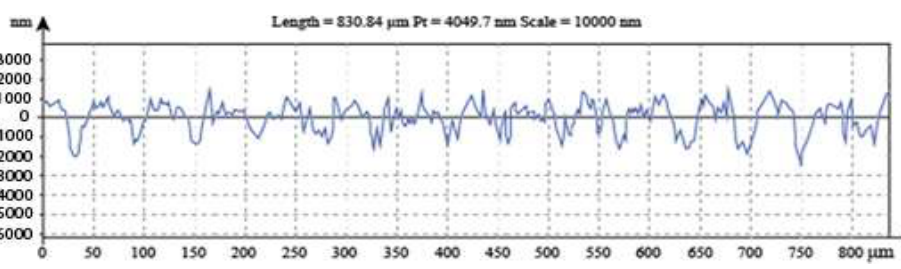
Figure 9. Surface roughness profile for the mild steel sample.